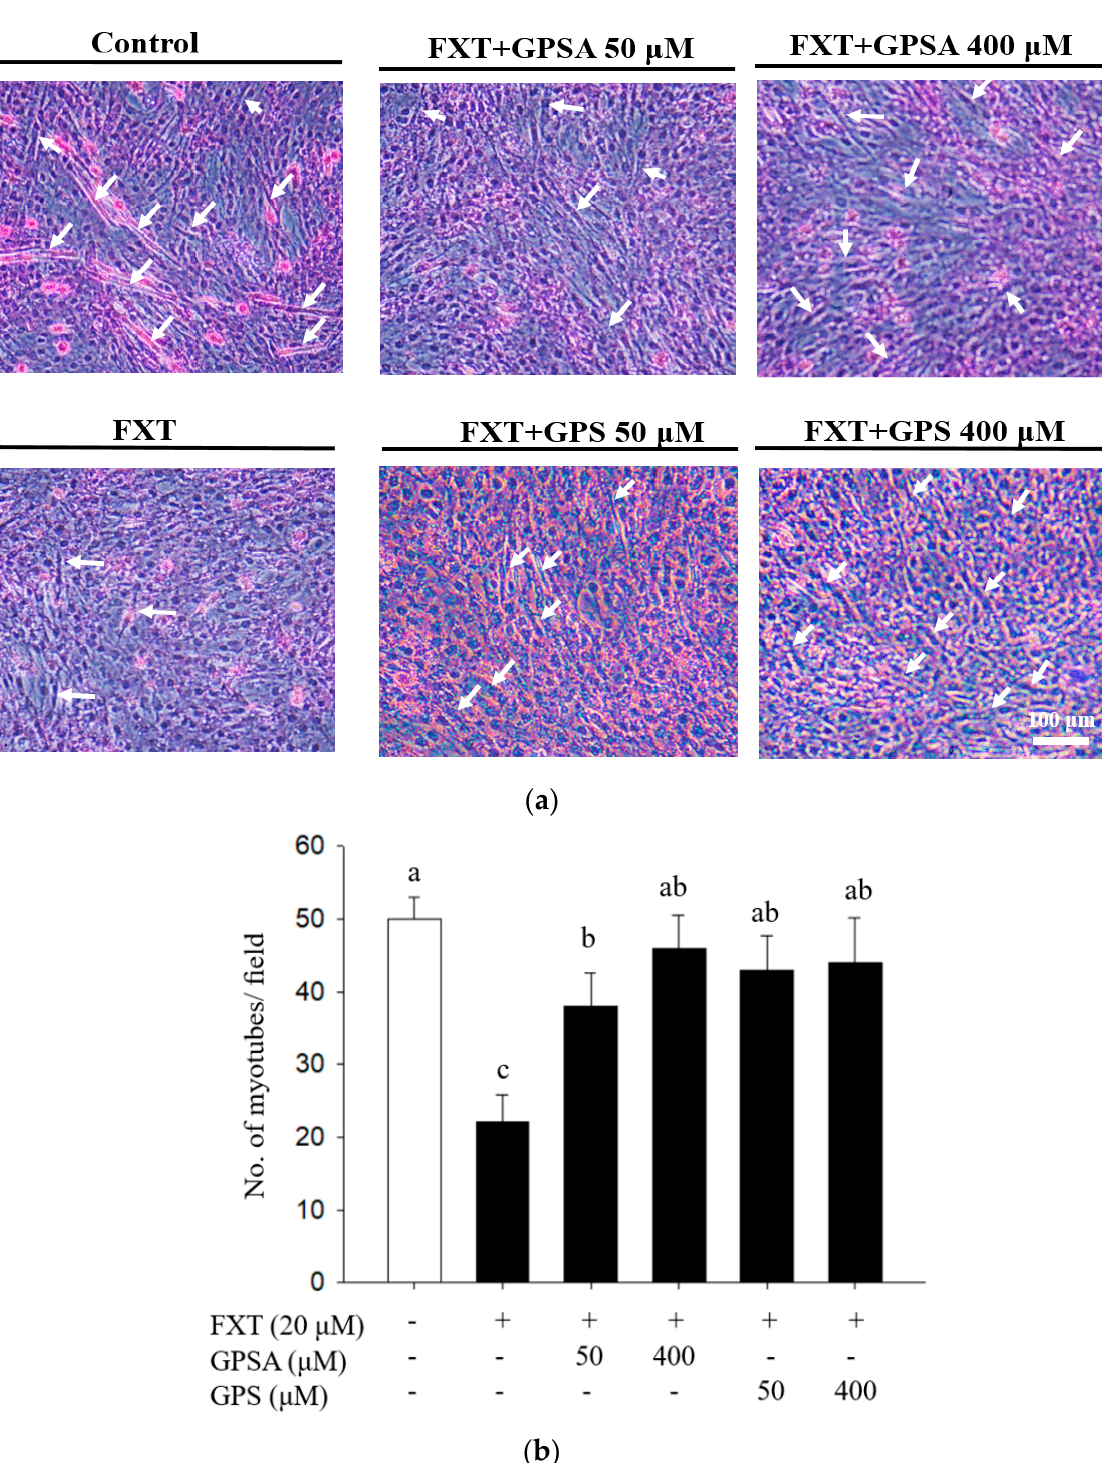
Figure 3. Effect of GPSA and GPS on myotube formation in FXT-treated C2C12 muscle cells. C2C12 cells were treated with PBS (vehicle control), FXT (20 µ M) together with GPSA (50 and 400 µ M) or GPS (50 and 400 µ M) for 48 h after 4 days of differentiation, respectively, and observed by H&E staining. ( a ) H&E staining of cell morphology. Myotubes were examined with a phase-contrast light microscope (Olympus CKX41). Original magnification, × 200. Scale bar indicates 100 µ m. The arrow signs indicate the survival myotubes. ( b ) The number of myotubes was calculated as three random regions per group. Data are expressed as mean SD ( n = 3). Different letters in lowercase indicate significance between one another as p < 0.05.